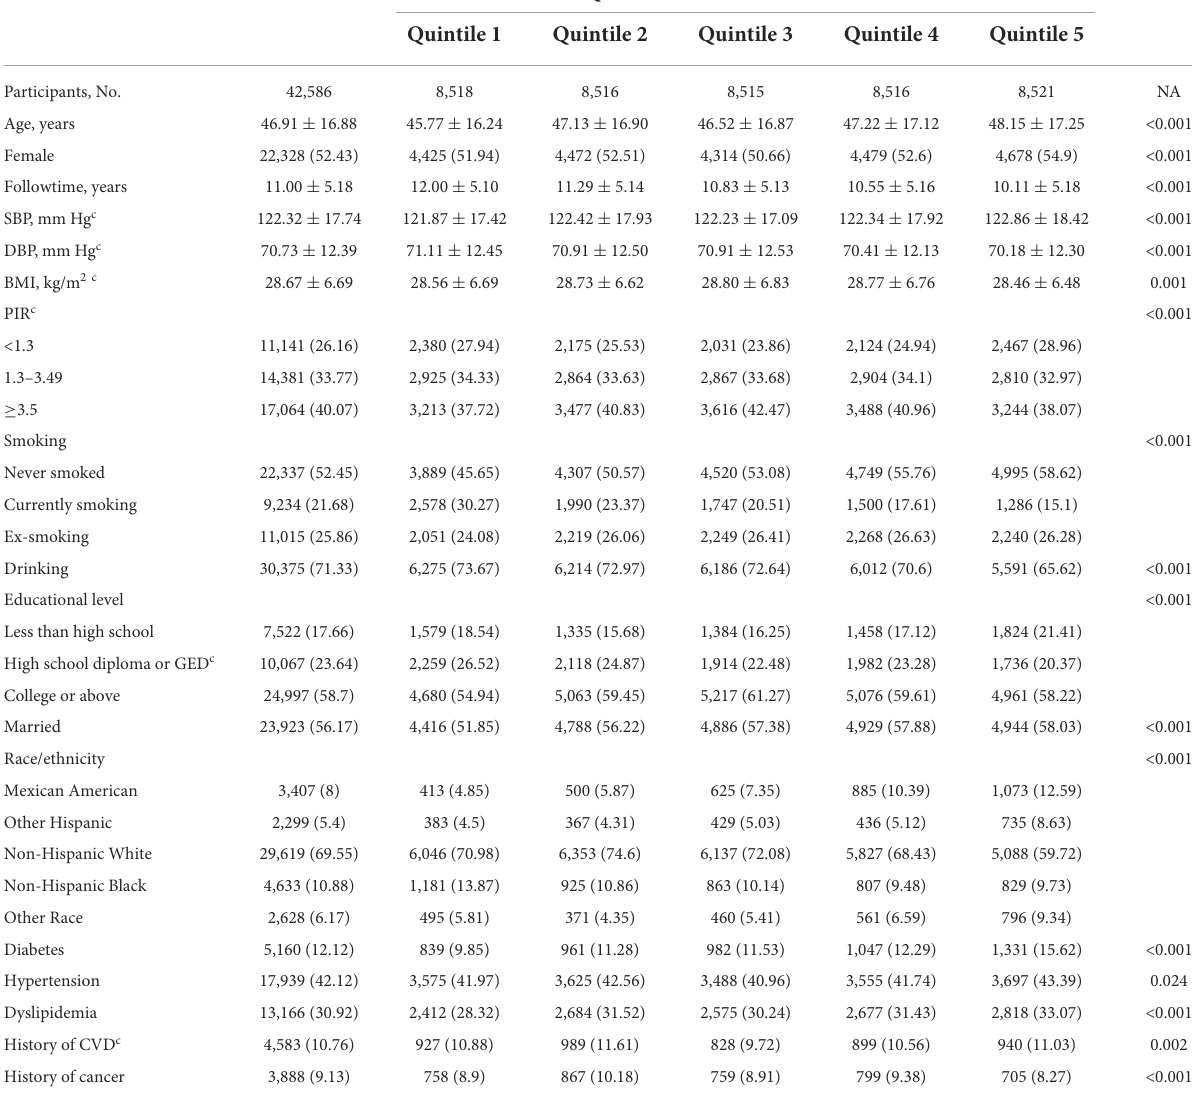
TABLE 1 Characteristics of study participants according to quintiles of resistant starch